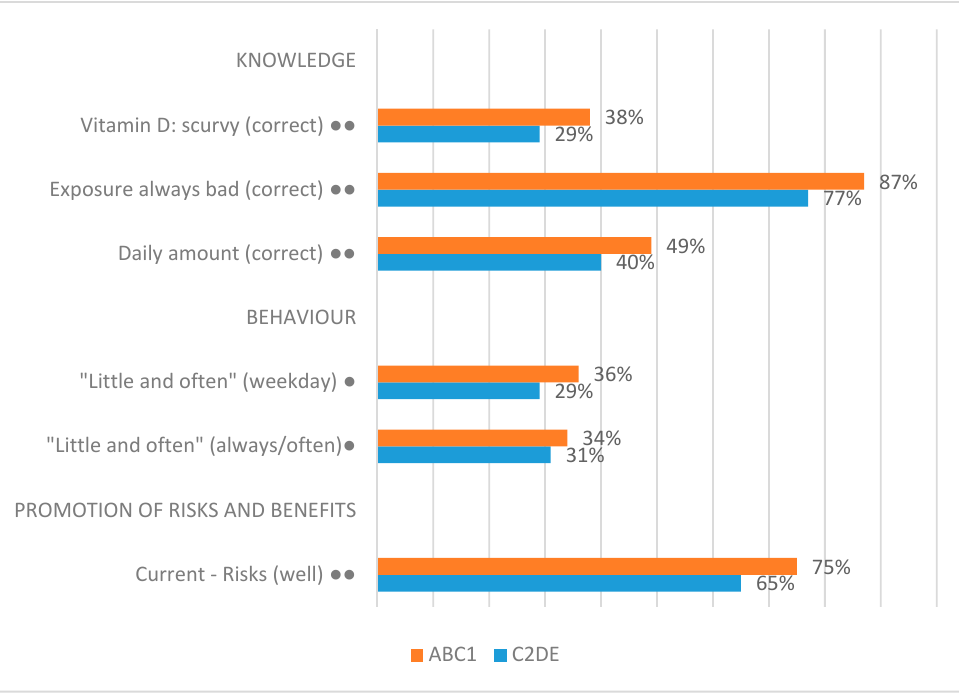
Figure 8. Significant socio-economic group differences in survey responses. A single dot indicates a significant difference in response at 0.05 (95%) and two dots signify a significant difference at 0.0005 (99.95%).